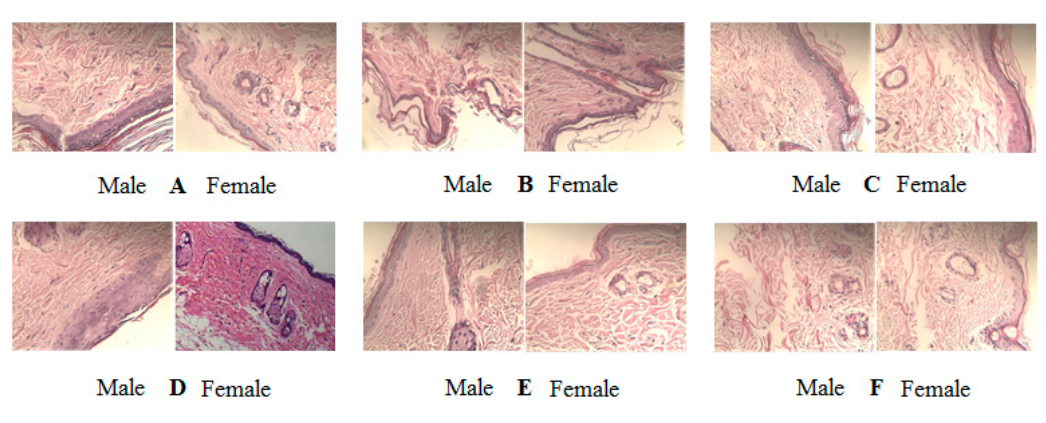
Figure 4. Color of rats’ skin after treatment. * p < 0.05, VD 3 liposomes vs. VD 3 solution for female rats;